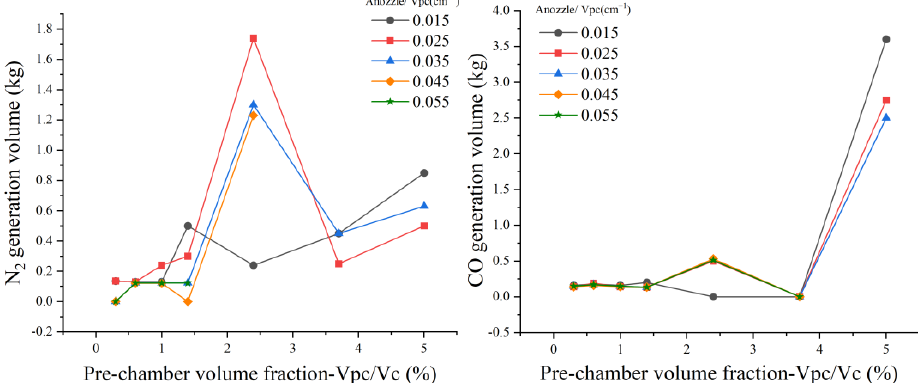
Figure 12. Increase in the mixing ratio in the main chamber.